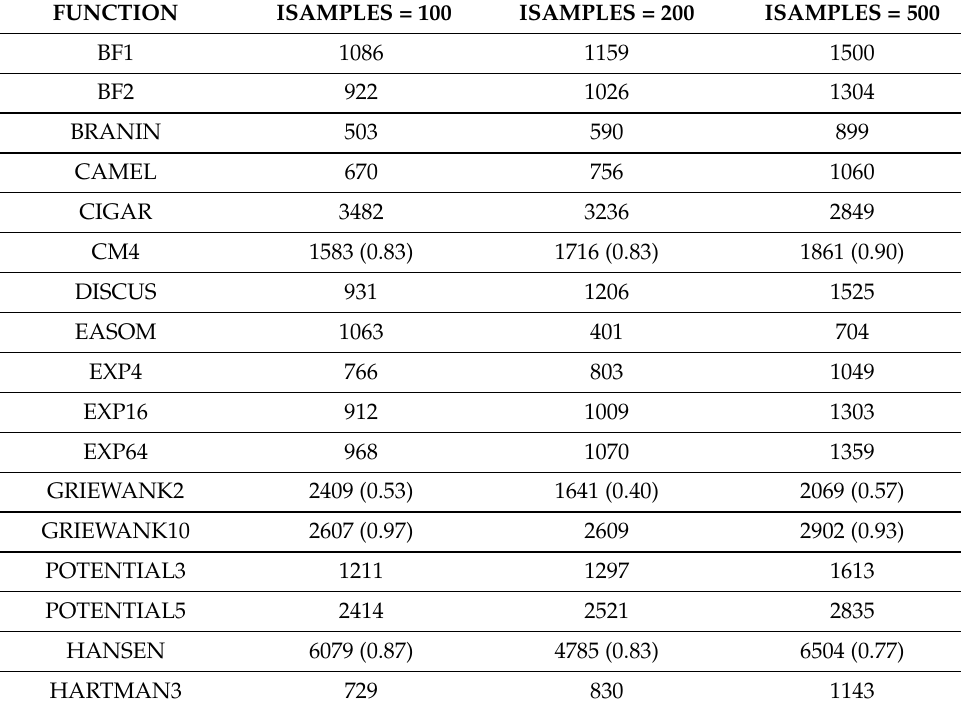
Table 3. Experimental results for the proposed method with N =